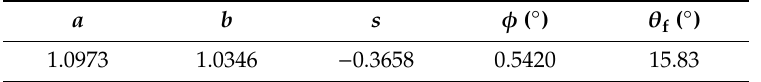
Table 2. The numerical solutions of OR and IO determined by the 2D O-line